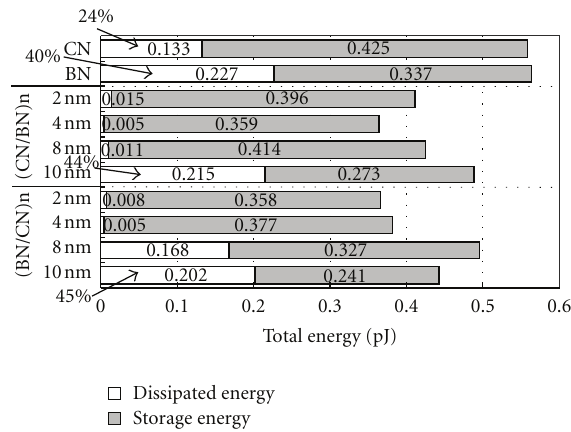
Figure 6: Dissipated and storage energies of (CN/BN)n and (BN/CN)n films, measured by nanoindentation